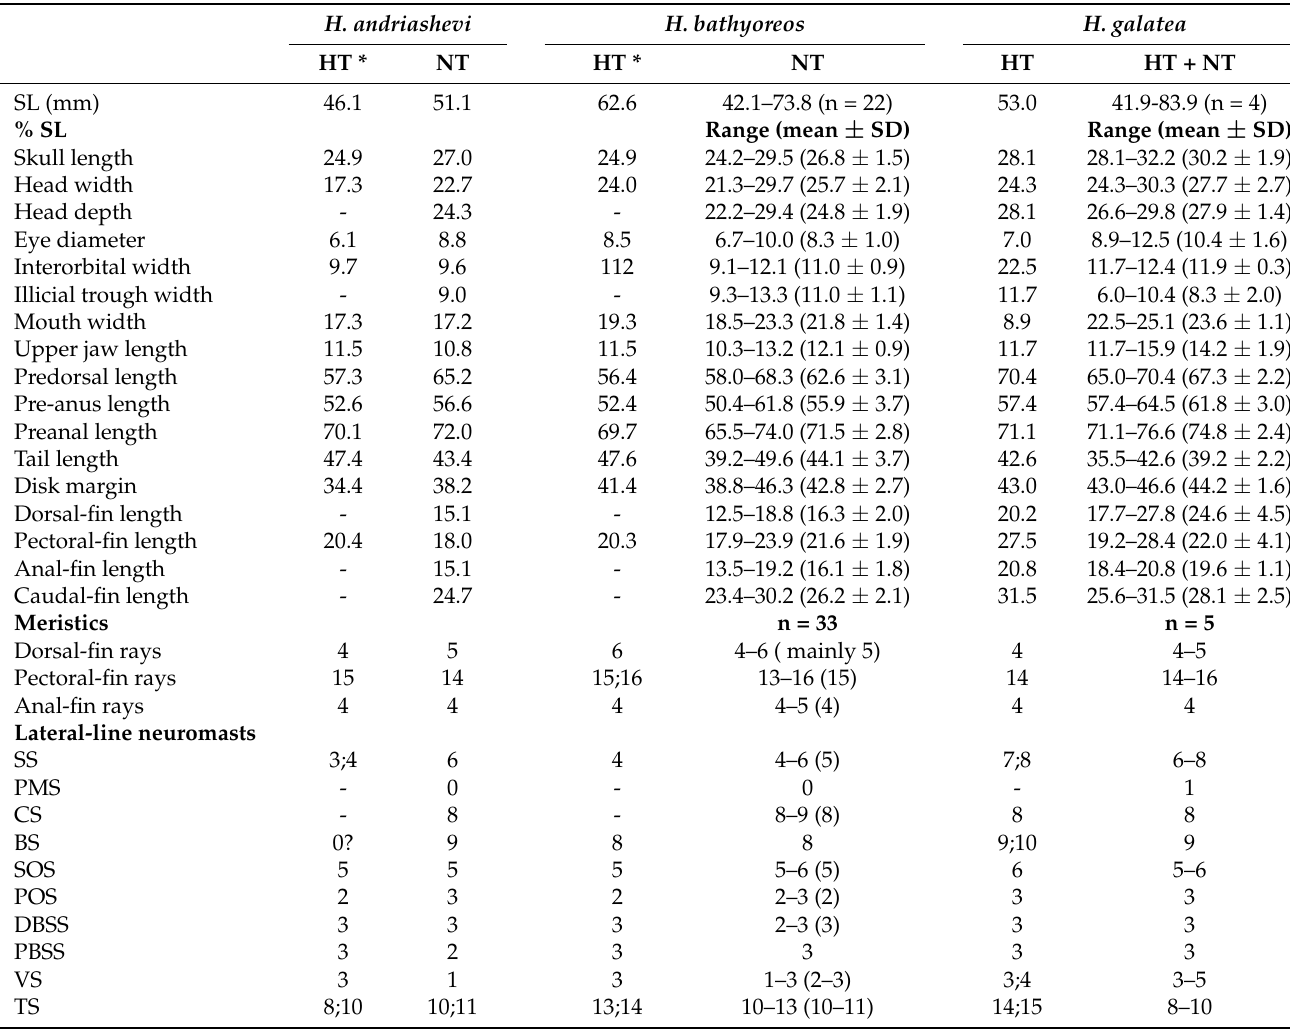
Table 3. Morphometric and meristic data of H. andriashevi , H. bathyoreos and H. galatea .* Data taken from Bradbury (1988). DBS = Dorsal branch of subopercular. HT = holotype. NT = Nontype(s). H.